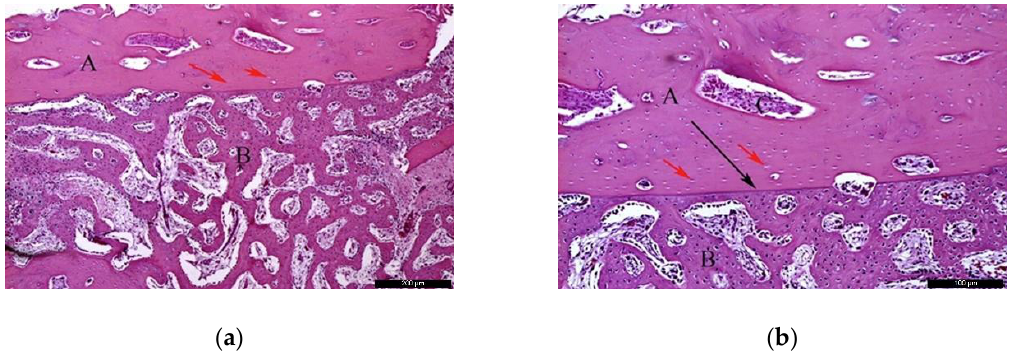
Figure 4. Histological analysis of the AG at 60 days. ( a ) Autogenous bone graft (A) in contact with the newly formed bone (B), and anucleated cells suggesting the presence of osteoblasts (red arrows). Hematoxylin and eosin stain at a magnification 40×; ( b ) Autogenous bone graft (A) and newly formed bone (B) separated by a cement line (black arrow) and osteocytes (red arrows). Hematoxylin and eosin stain at a magnification 125×.